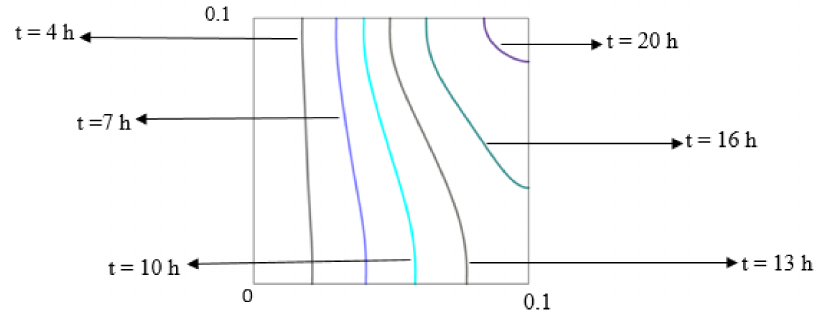
Figure 7. Streamlines in the velocity field of molten silicon.